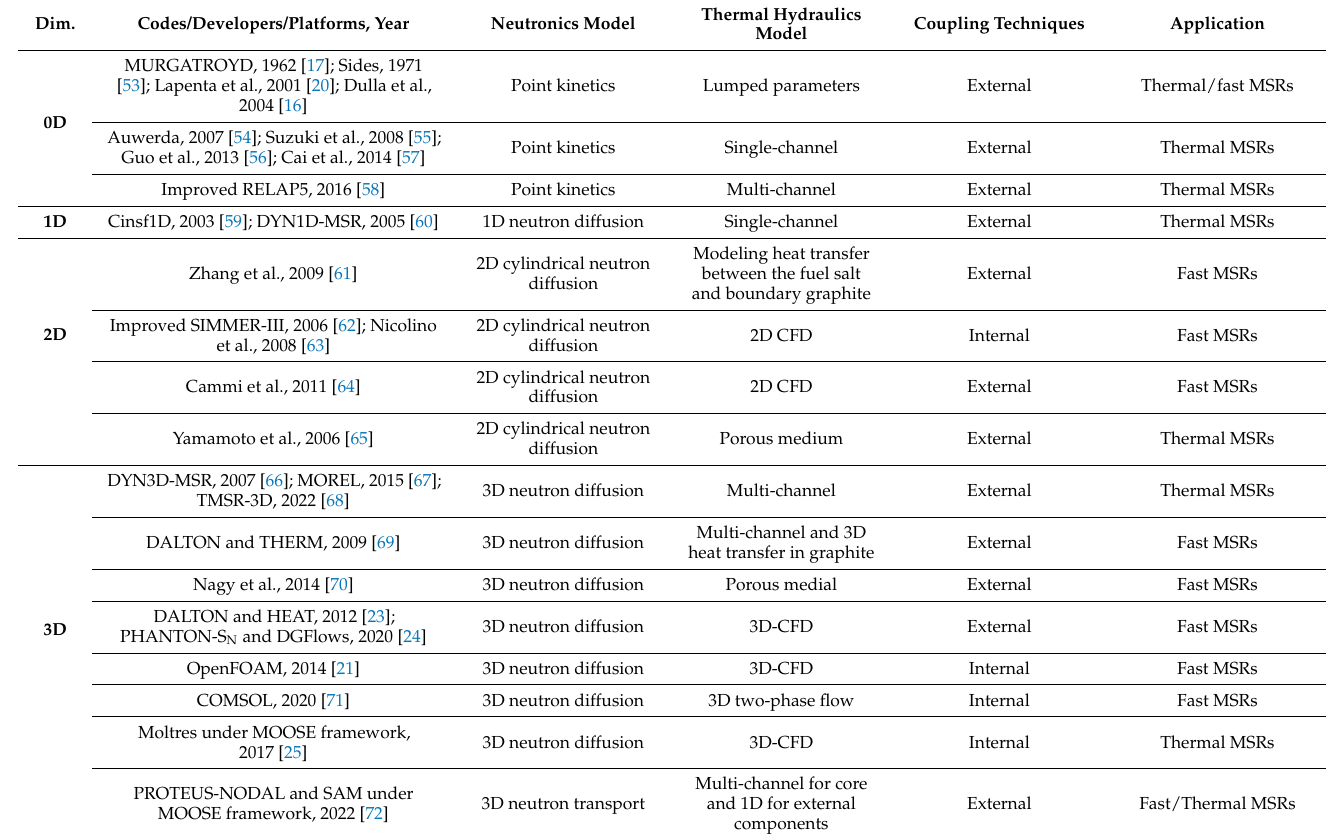
Table 1. Summary of the current N-TH coupling